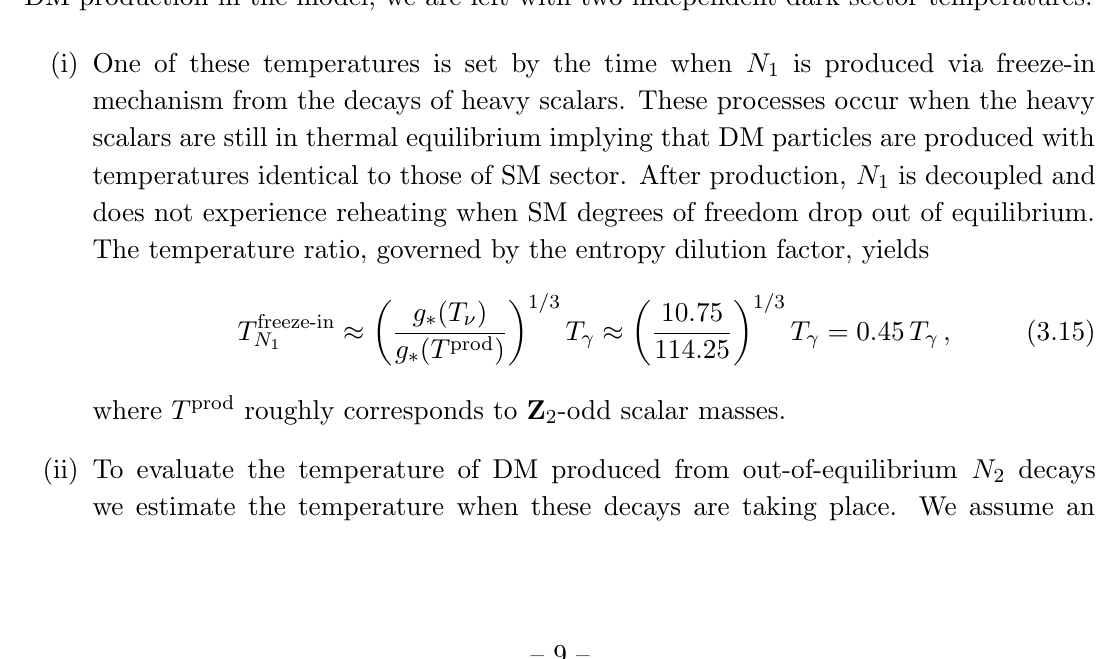
Figure 1 . In the left (right) panel we show the momentum distribution function f N both DM production mechanisms, taking m Blue and red curves correspond to freeze-in and N 2 late-time decays,